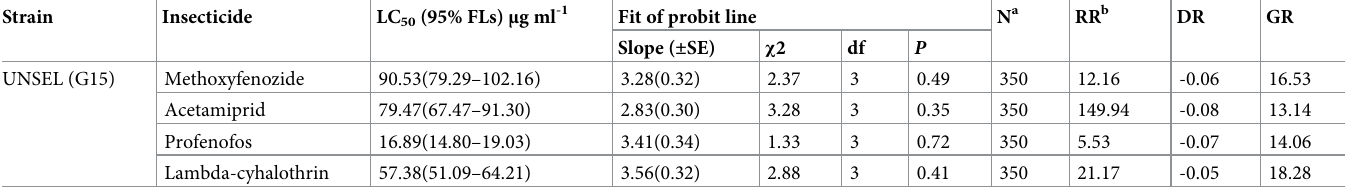
Table 3. Stability and decrease rate of resistance to methoxyfenozide and other tested insecticides in Chrysoperla carnea . Strain